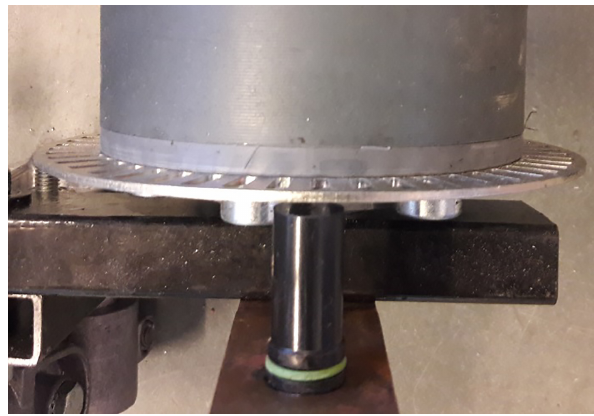
Figure 6. Gearwheel sensor mounted at base roller. and reading head are mounted directly to the rear roller and base respectively as seen at Fig. 6.